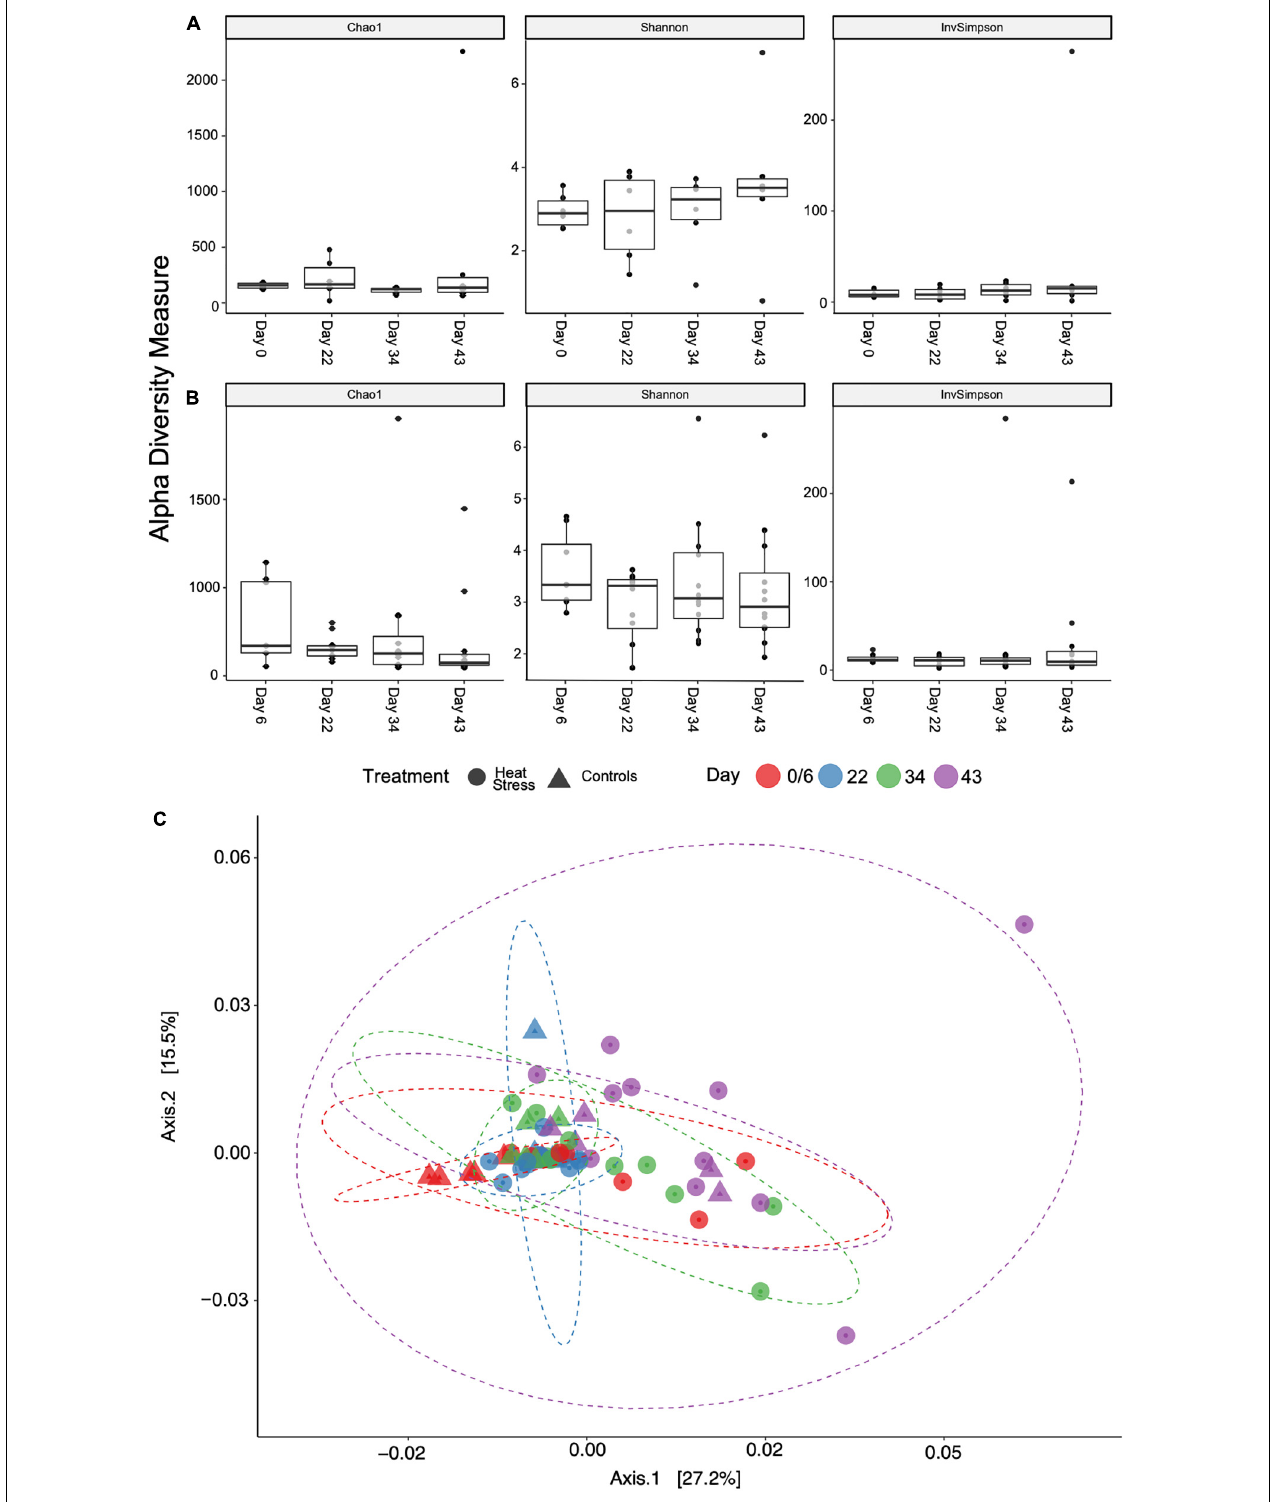
FIGURE 4 | Alpha diversity metrics sorted by treatment over time for (A) control and (B) heat stress treatments. There were no statistical differences between timepoints. Samples were rarefied to a depth of 22,900 reads per sample for beta diversity (C) . PCoA plot shows weighted UniFrac distance, sorted by treatment and sampling date. Ellipses are normally distributed data